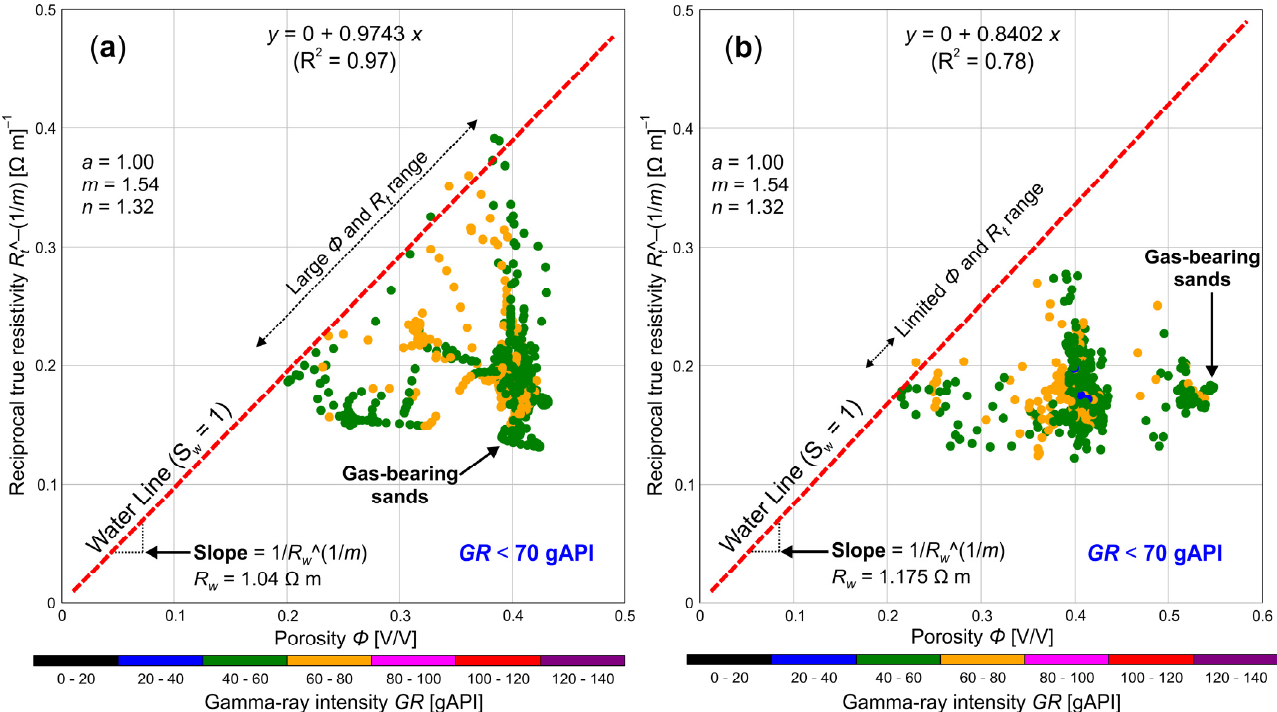
Figure 10. Hingle-type resistivity–porosity crossplots based on log-derived density porosity ( φ D ) and parameters ( ρ ma , m , n ) obtained from core analyses (RCAL and SCAL). ( a ) B-2 well (528 data levels), showing water-bearing intervals with large porosity and resistivity range; ( b ) B-4 well (581 data levels), showing water-bearing intervals with narrow porosity and resistivity